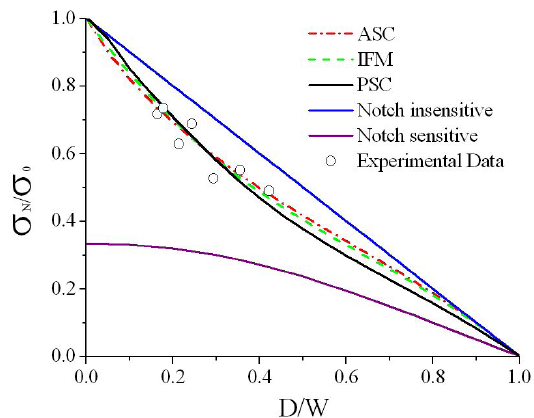
Figure 3. Comparison between experimental data and PSC, ASC, IFM and MSC , a and a . 0 0